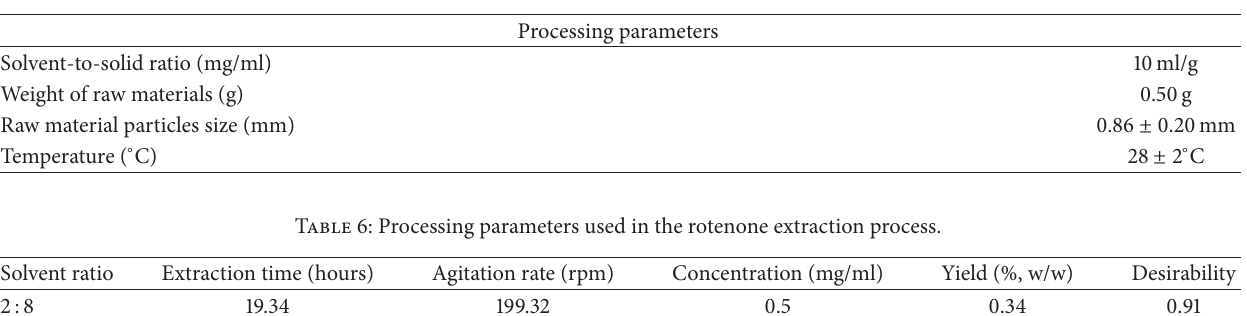
Table 5: Processing parameters used in the rotenone extraction process.